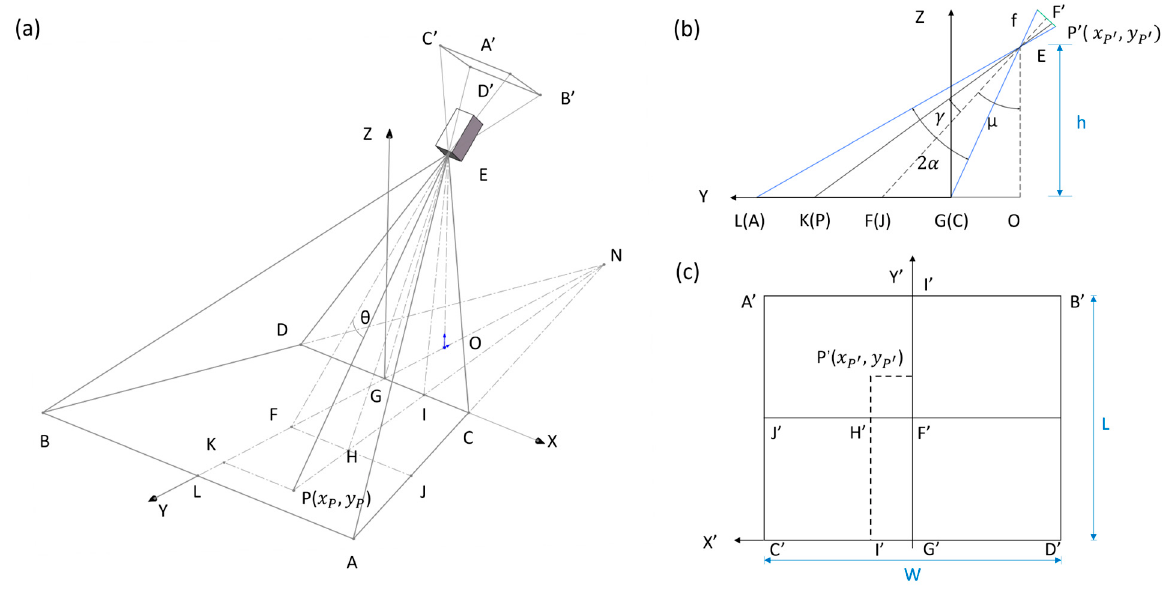
Figure 2. Diagram illustrating the camera’s field of view. ( a ) Object plane coordinate view; ( b ) projected view along the X-axis direction; ( c ) top view of the image plane.